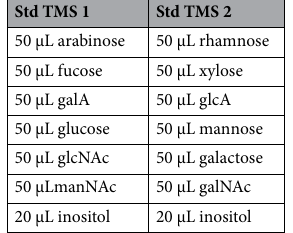
Table 1. Standard TMS mix preparation.